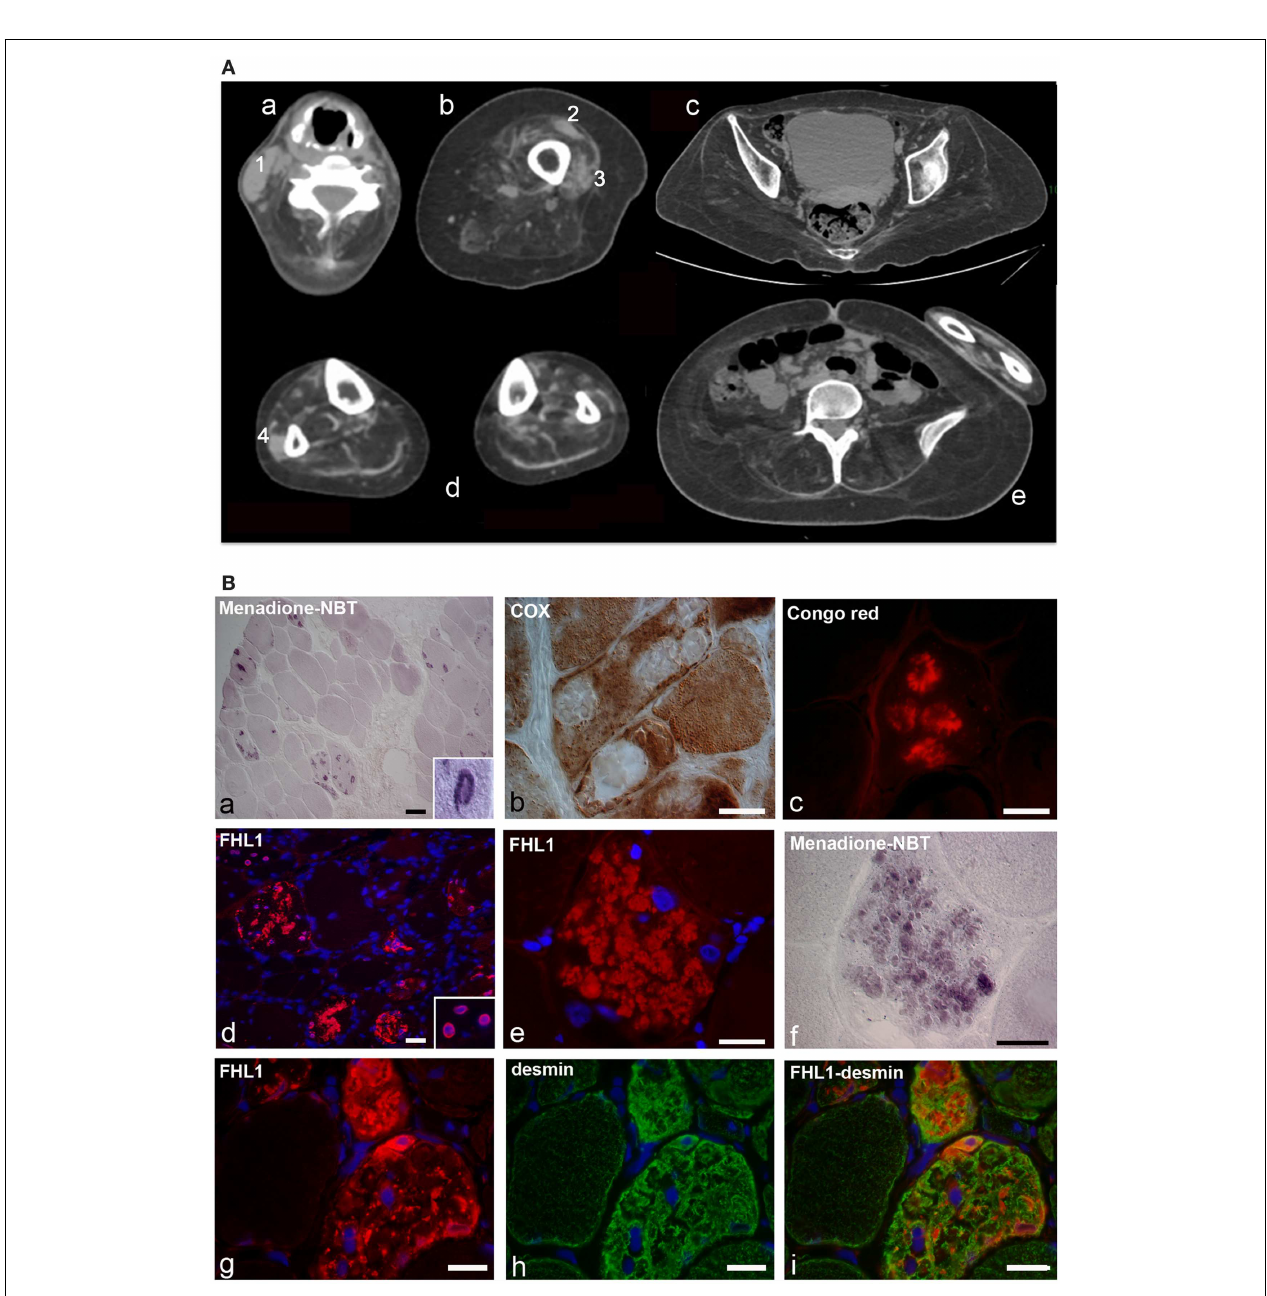
muscle fibers, as revealed by menadione-NBT staining (a). Granular deposits are detectable at the nuclear rim of some myonuclei (a, inset). RBs appear devoid of oxidative activity (cytochrome oxidase, COX in b) and display affinity to Congo red staining (c). Immunofluorescence analysis of FHL1 shows protein accumulation throughout the cytoplasm of several muscle fibers (d) and around myonuclei (d, inset). FHL1 immunolabeling (e), followed by menadione-NBT staining (f), demonstrates that FHL1 accumulates in RBs (f). Double labeling for FHL1 and desmin (g–i) shows a marked increase of desmin in FHL1-accumulating myofibers. Scale bar, 20 µ m.